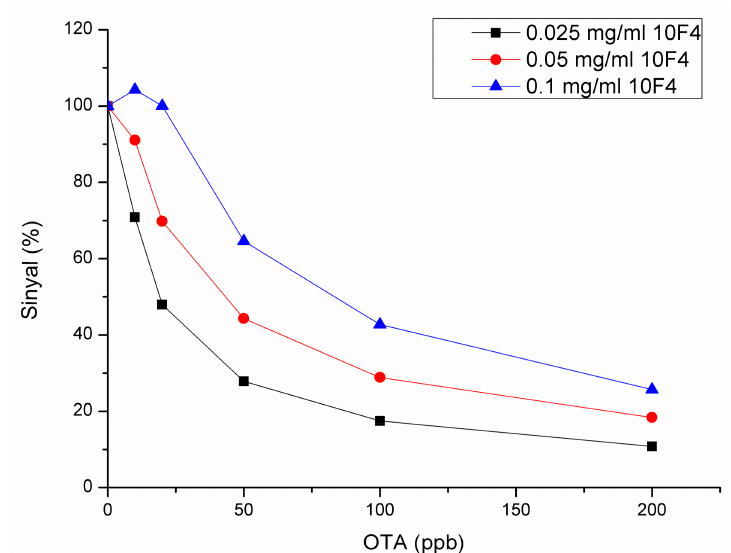
Figure 6. Selection of optimal antibody concentration for OTA measurement in a competitive assay